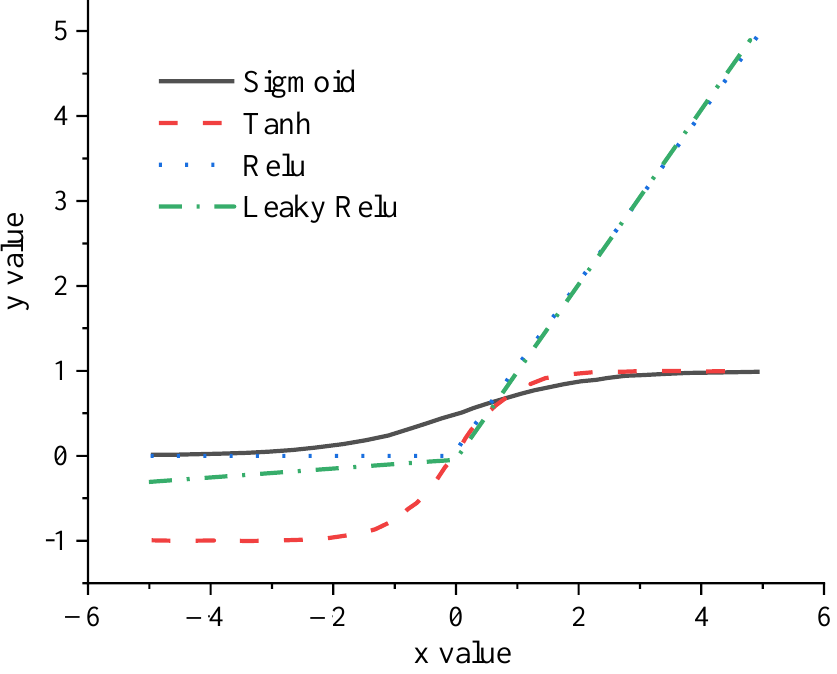
Figure 4. The plots of the activation functions.